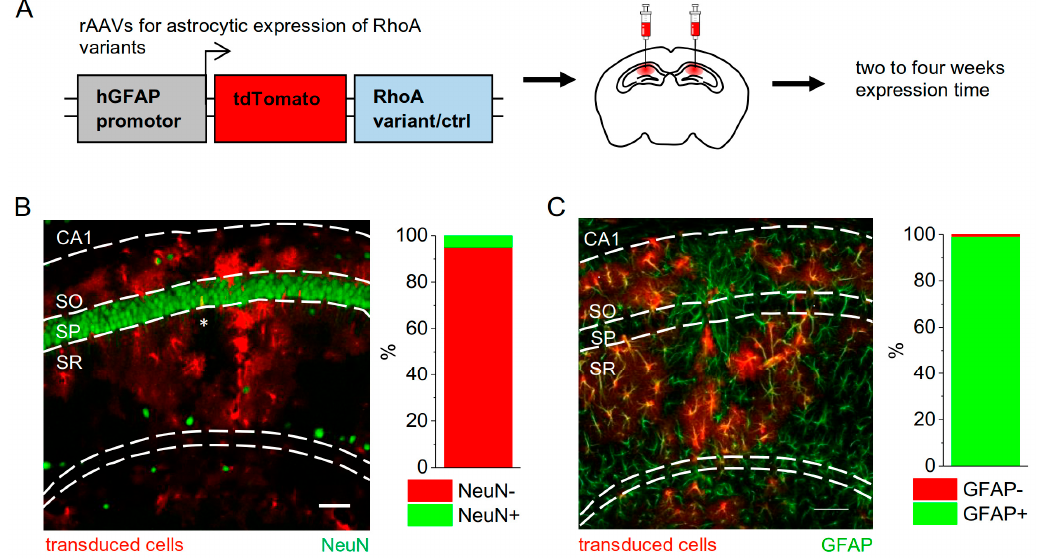
Figure 3. Strategy and specificity for manipulating astrocytic RhoA activity in vivo. ( A ) Schematic representation of the recombinant adeno-associated virus (rAAV) design. A human GFAP promotor was used to drive expression of the RhoA variants RhoA-WT/DN/CA fused with tdTomato or only of tdTomato (ctrl). rAAVs were injected into the dorsal hippocampus. Experiments were performed two to four weeks after virus injections. ( B ) Cellular specificity was tested by visualising transduced cells and neurons using immunohistochemistry. It was found that 94.9 ± 1.9% of the transduced cells were negative for the neuronal marker NeuN (NeuN+, n = 7 tissue slices from 3 animals, 977 cells in total). ( C ) The vast majority of tdTomato-expressing cells were positive for the astrocyte marker GFAP (99.2 ± 0.18%, n = 9 tissue slices from 3 animals, 2096 cells in total). Scale bars in ( B , C ) 100 μ m. Note that data presented in ( B , C ) are from independent sets of immunohistochemistry experiments. * in B indicates the approximate virus injection site.